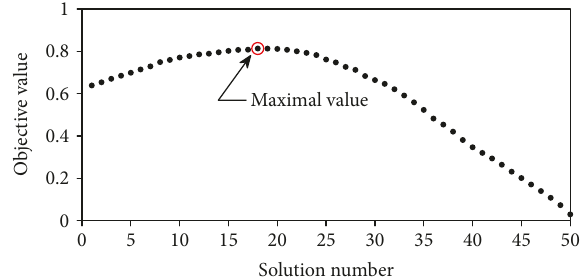
Figure 18: The objective value of the Pareto optimal front for case III.